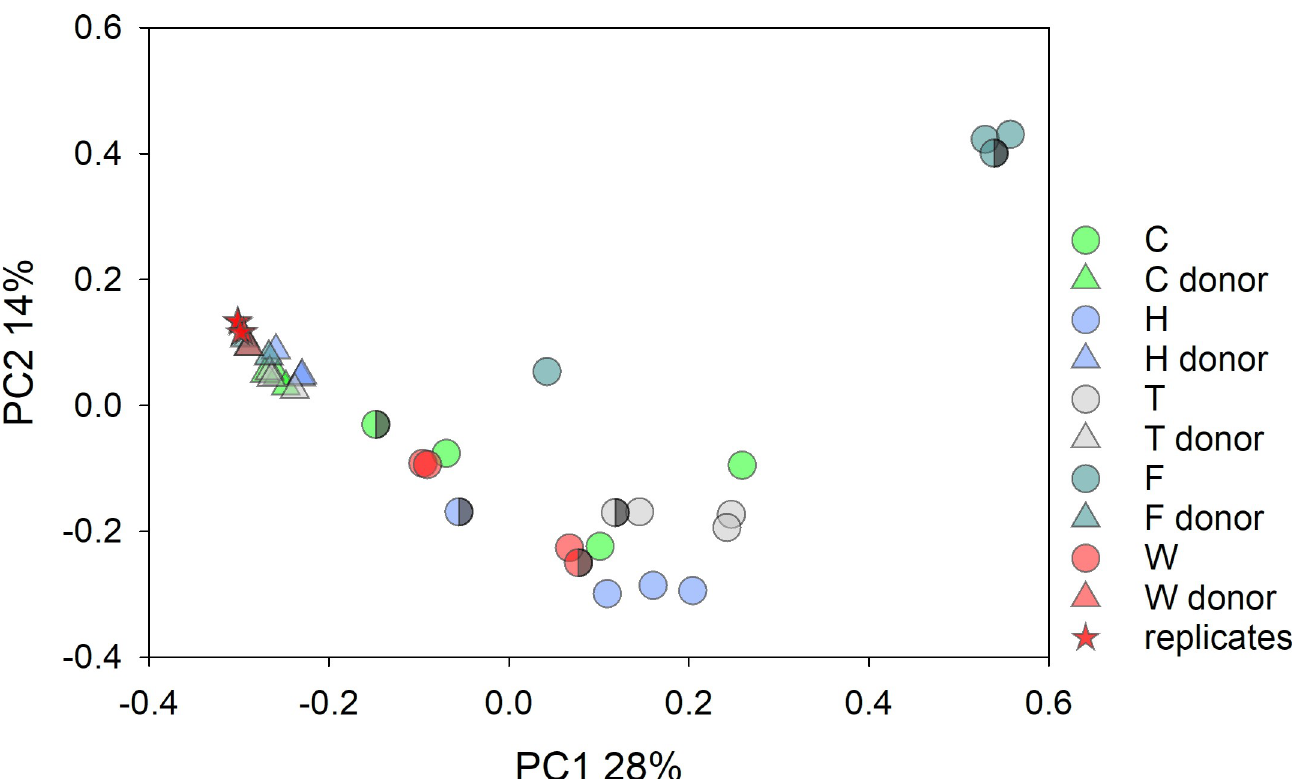
Fig 5. Principal coordinate analysis of FMT donors and recipients. Matched recipient and donor are indicated with the same color. Triangle, donor; circle, recipient. The same color key as in Fig 1 is used. Semi-filled symbol indicates day 4 collection. Stars are technical replicates obtained by processing and sequencing 2 samples from donor horse To